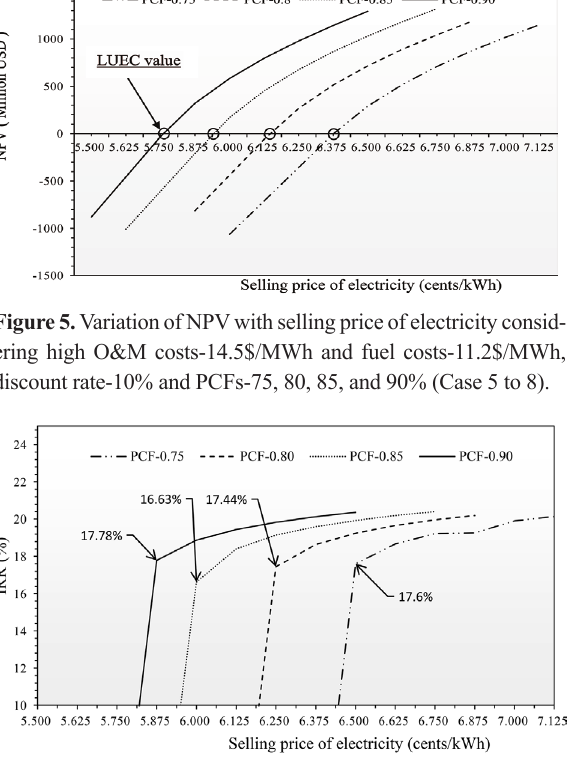
Figure 4. Variation of IRR with selling price of electricity con - sidering low O&M costs-7.82$/MWh and fuel costs-4.50$/ MWh, discount rate-10% and PCFs-75, 80, 85, and 90% (Case 1 to 4).